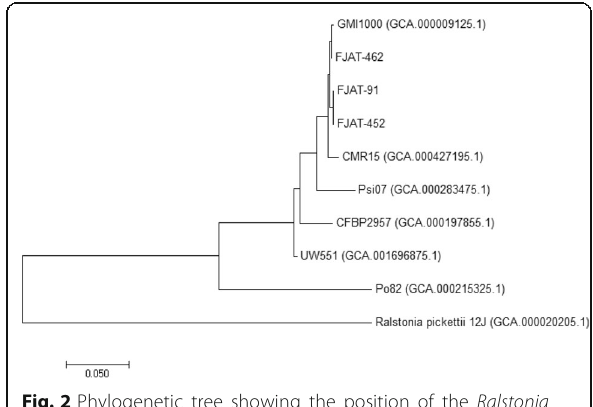
Fig. 2 Phylogenetic tree showing the position of the Ralstonia solanacearum sequenced in this study, relative to other sequenced strains from the same species. The phylogenetic tree was constructed using concatenated alignments of the marker genes fliC , hrpB and pehA . The evolutionary history was inferred by using the Maximum Likelihood method based on the Tamura-Nei model [27]. Evolutionary analyses were conducted in MEGA7 [28]. GenBank accession numbers are displayed within brackets. Ralstonia pickettii 12 J was used as an outgroup